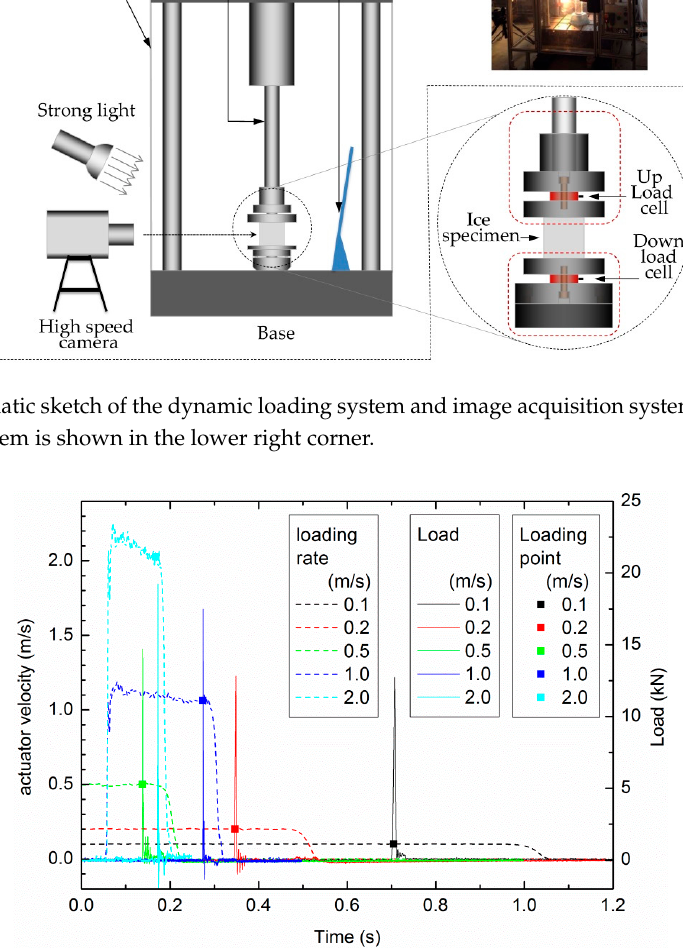
Figure 5. Actuator velocity versus time profiles (shown as dotted lines) and load versus time profiles at different loading rates (shown as solid lines). Each intersection points of two kinds of profiles is located in the quasi-horizontal section of the corresponding actuator velocity profile, indicating each ice samples is loaded at an approximately constant loading rate.